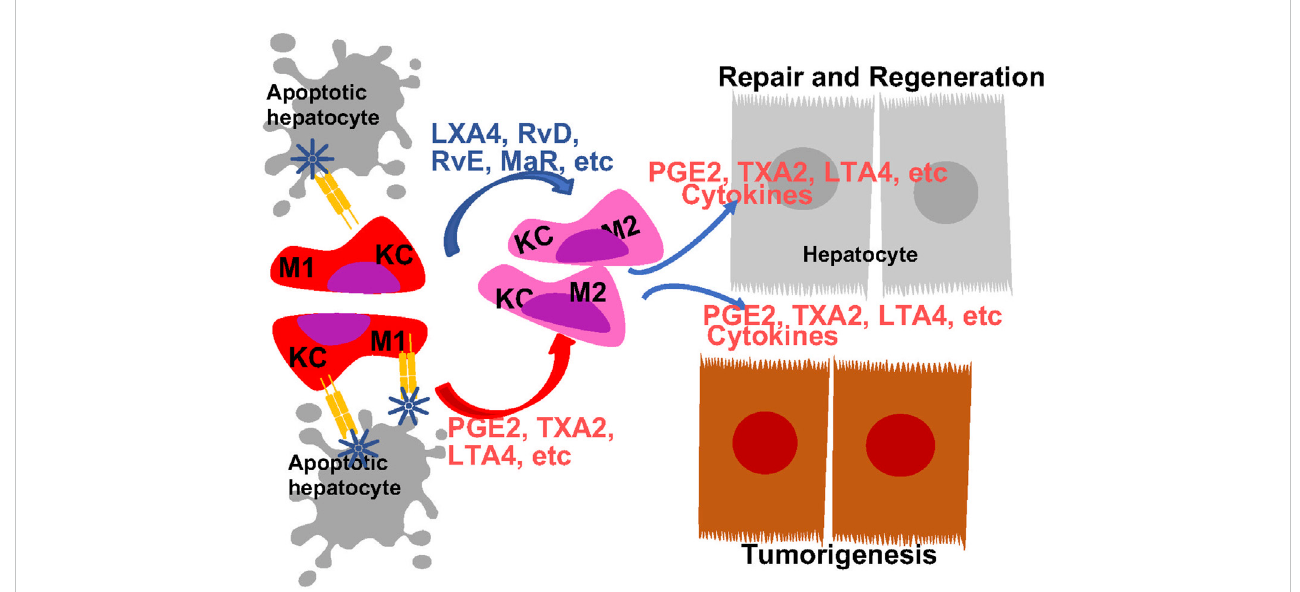
Regulation of Macrophage Polarity by Eicosanoids and Oxylipins and Its Role inLiver Disease Progression.Liver residentmacrophages, Kupffer cells (KC) are the fi rst responders to liver injury. In response to injury, they are programmed to produce M1 proin fl ammatory cytokines to orchestrated in fl ammatory response. Both eicosanoids with proin fl ammatory functions and pro-resolving eicosanoids induces macrophage polarization towards M2 phenotype. The M2 polarized macrophage also produces eicosanoids to promote tissue regeneration an tumor growth.